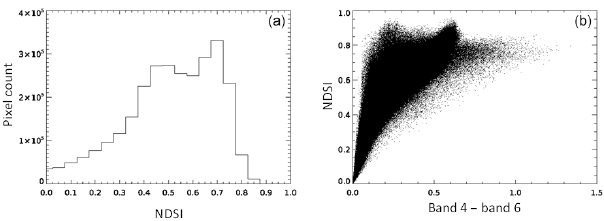
Figure 4. NDSI histogram (a) and scatterplot of NDSI versus VIS- SWIR difference (b) for the MOD10_L2.A2003010.1750.006 im- age in Fig. 2. Pixels restricted to snow only, i.e., NDSI > 0.0, and not masked as cloud in the NDSI_Snow_Cover dataset. Histogram was calculated with NDSI bin size of 0.05.